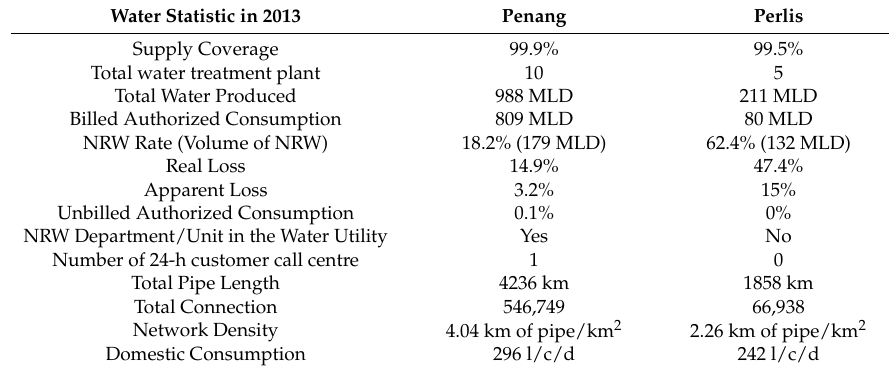
Table 1. Water Statistic and NRW-related Performance Indicators of Penang State and Perlis